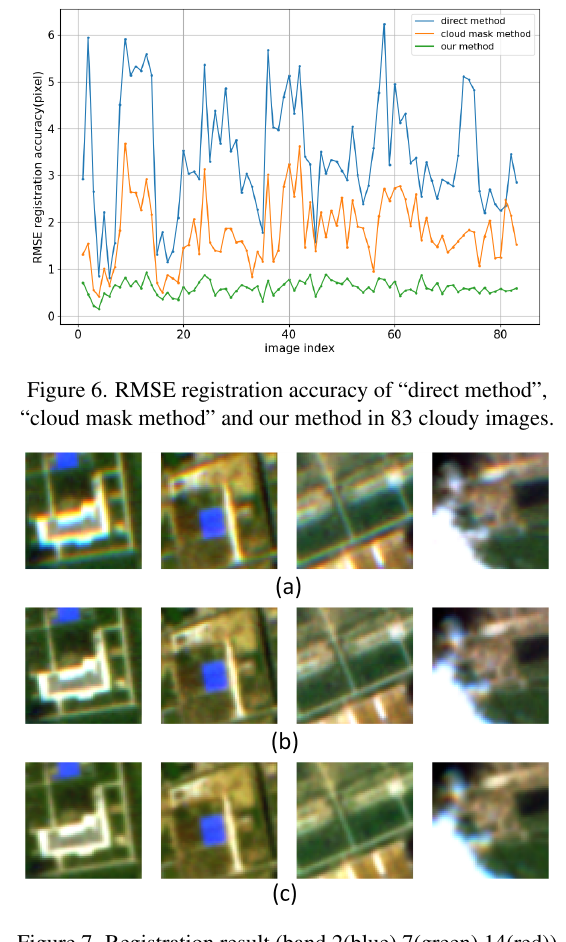
Figure 7. Registration result (band 2(blue),7(green),14(red)) comparison of different methods in cloudy images. (a) are results of the “direct method”. (b) are results of the “cloud mask method”. (c) are results of our method.